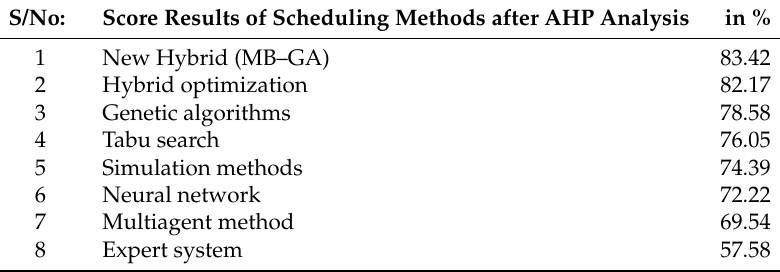
Table 9. Score results of best selected scheduling methods after AHP